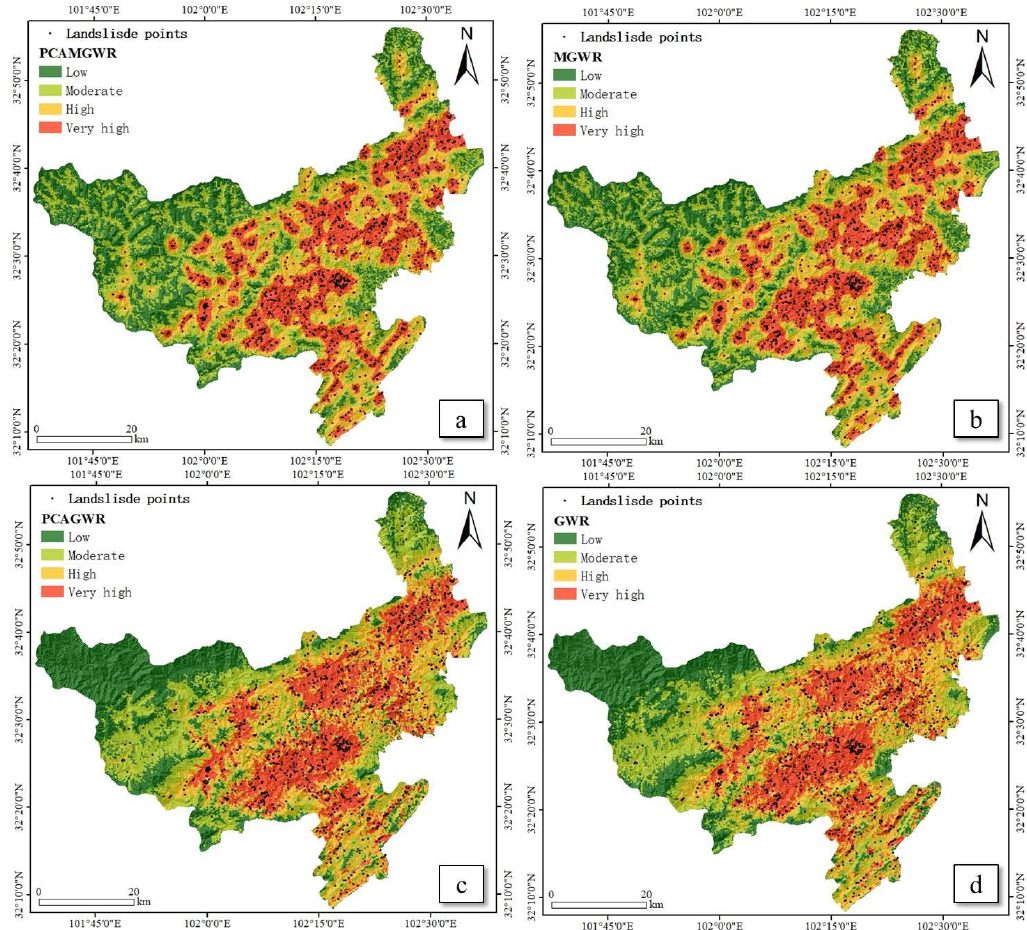
Figure 9. LSMs generated by models: ( a ) PCAMGWR, ( b ) MGWR, ( c ) PCAGWR, and ( d ) GWR.